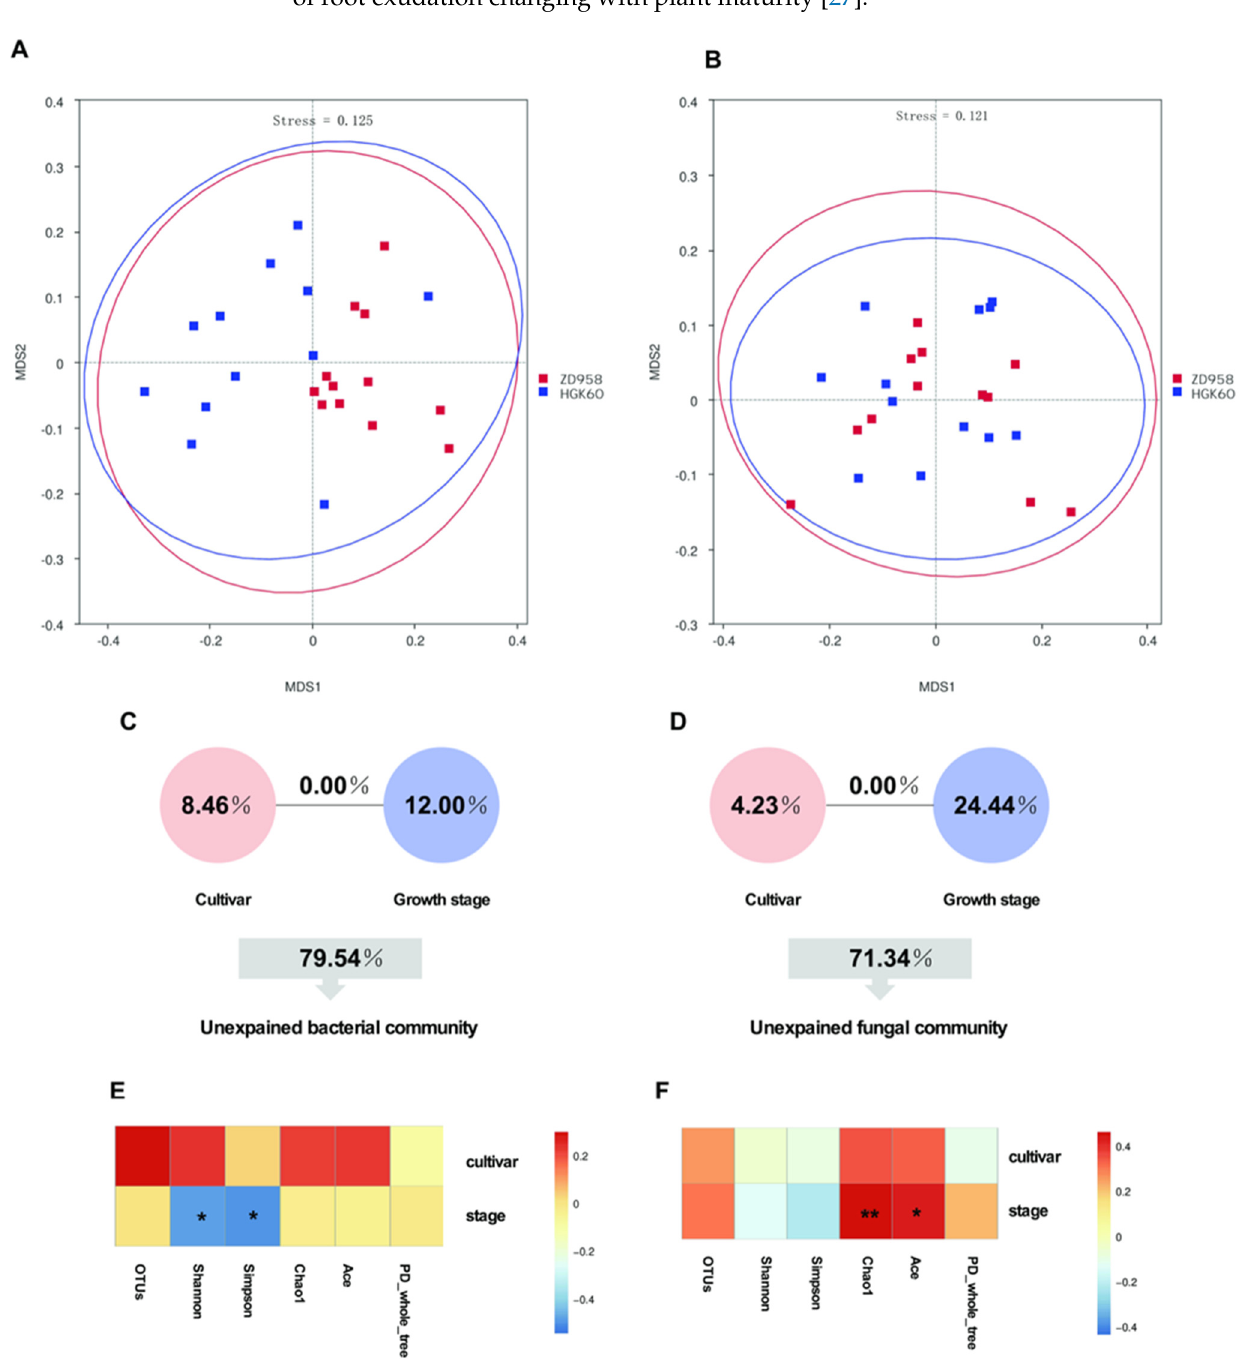
Figure 5. Effects of cultivar and stage on the rhizosphere bacterial and fungal communities. ( A , B ) Non-metric multidimensional scaling (NMDS) of bacterial and fungal community structures between cultivars, respectively; ( C , D ) variance-partitioning analysis (VPA) of the effects of cultivar, growth stage, and the interactions among these factors on the bacterial and fungal community structure. Circles show the percentage of variation caused by each factor alone. The unexplained variation is depicted in the squares at the bottom of the figure; ( E , F ) variance-partitioning analysis (VPA) of the effects of cultivar, growth stage, and the interactions among these factors on the bacterial and fungal community structures, respectively. ** p value < 0.01. * p value < 0.05.